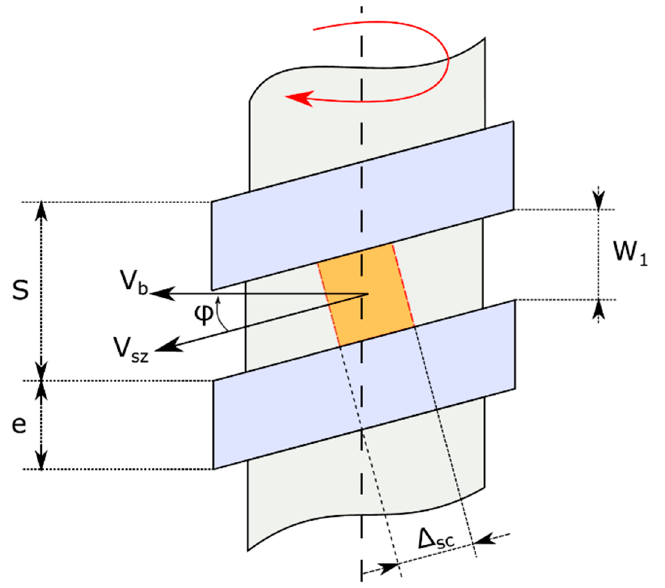
Figure 4. Solid conveying kinematics and geometry; W 1 —channel width at mean diameter, S—screw lead, e—flight width, φ —helix angle, Δ sc —computational step in downstream direction, V b —barrel velocity, V sz —solid body velocity.